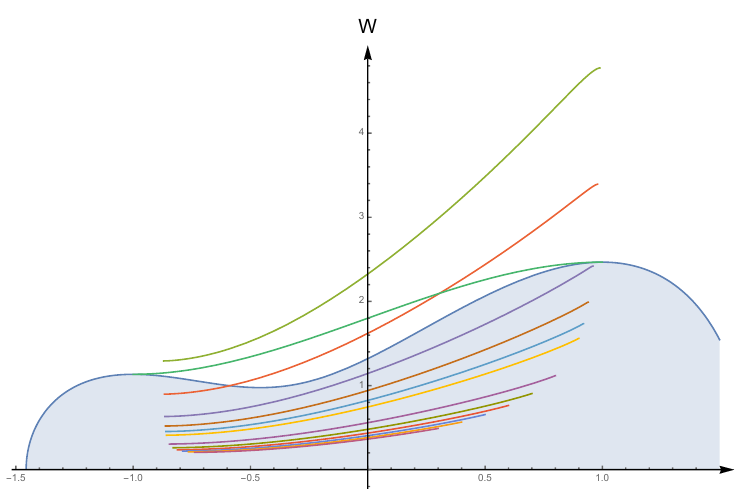
Figure 29 . The blue curve bounding the shaded region represents the curve B ( (cid:30) ) which bounds superpotentials at zero temperature (see (A.18)). It is presented here to locate the extrema of the potential between which the zero temperature solution (cid:13)ows. The green curve which starts at -1 with value B ( (cid:0) 1) and extends until (cid:30) = 1 where its value is B (1) corresponds to the zero-temperature solution. The remaining curves correspond to (cid:12)nite-temperature superpotentials solving (A.2) and (A.3) with boundary conditions (A.8){(A.9) for the potential (5.20){(5.21). The values of W increase as the horizon position takes values closer and closer to the IR extremum at (cid:30) = v . None of the black-hole solutions reach the local minimum of V at (cid:30) = (cid:0) 1, they all bounce for (cid:30) > (cid:0) 1. The position of the bounces and their progression as (cid:30) h approaches v is clearer when looking at W 0 ( (cid:30) ), as is done in (cid:12)gures 30 and